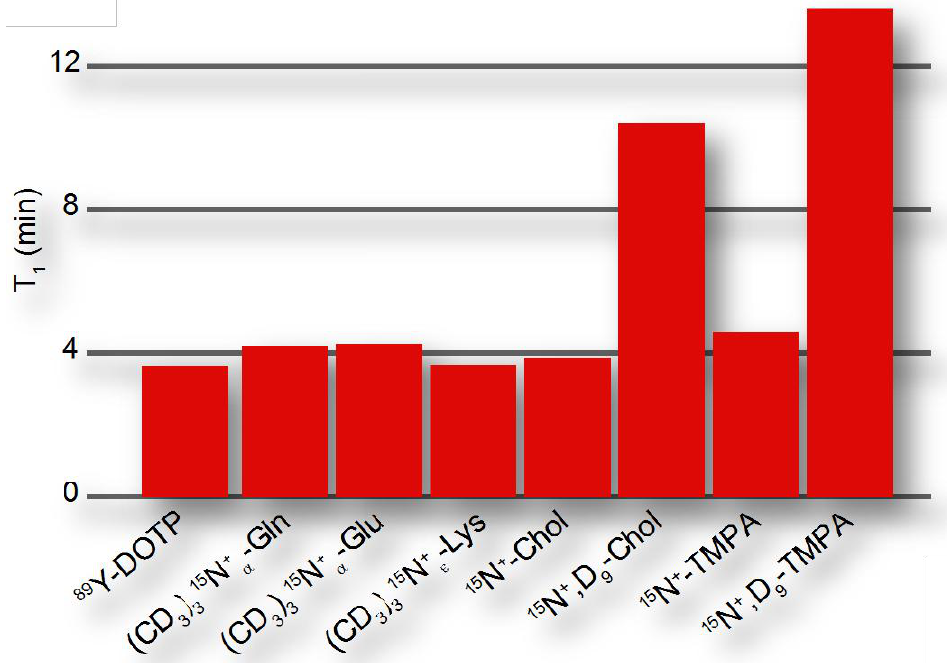
Figure 4. Exponential decay time constants for hyperpolarized reporter groups in various designed probes, reaching up to several minutes in symmetrically substituted, non-protonated sites. The reported time constants were derived at 9.4 T and 25 °C for 89 Y-DOTP [28], at 14.1 T and 37 °C for permethylated amino acids [51] and at 14.1 T and 30 °C for choline- and TMPA-based probes